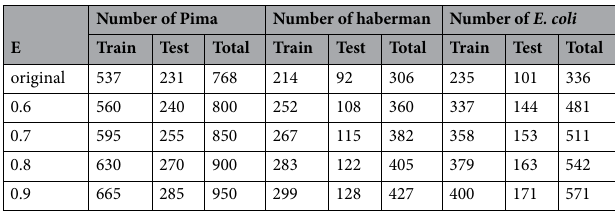
Table 4. The number of samples used in the experiment.